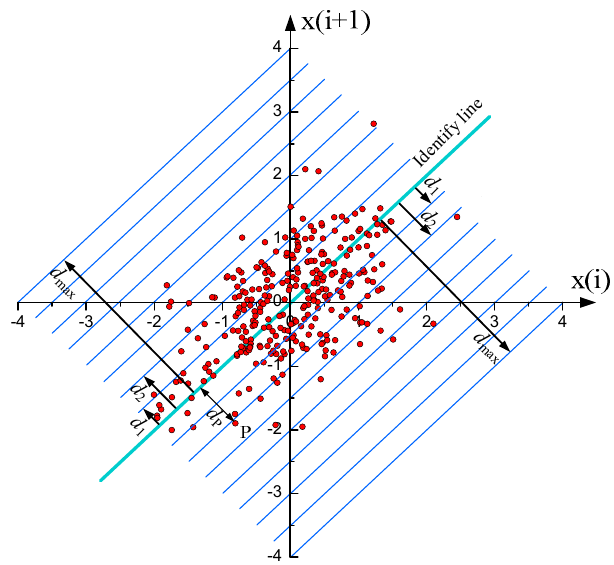
Figure 16. Fluctuating signals from electrode pairs 4 and 5: ( a ) Uso = 0.584 m/s, +3°; ( b ) Uso = 0.584 m/s, − 3°.